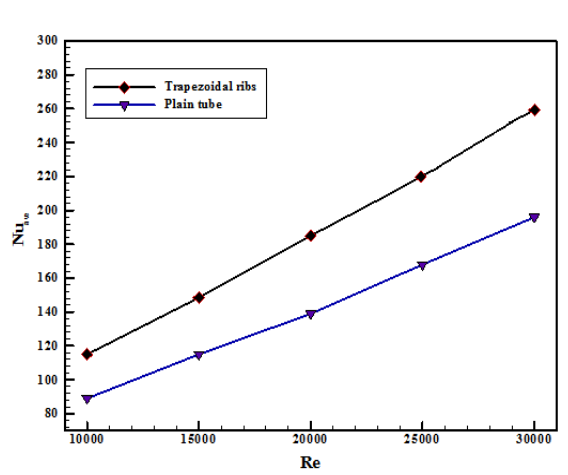
Fig. 5. Variation of average Nusselt number with trapezoidalat different Reynolds